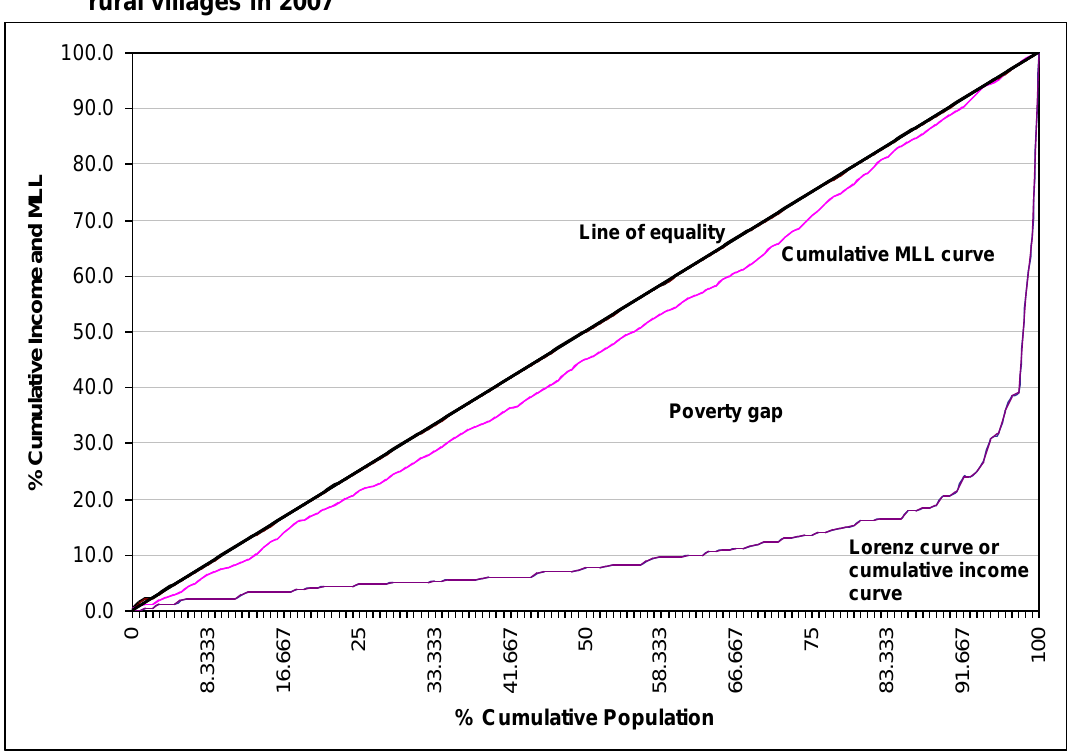
Figure 2: The poverty gap and Lorenz curve of the sample population in selected Limpopo rural villages in 2007